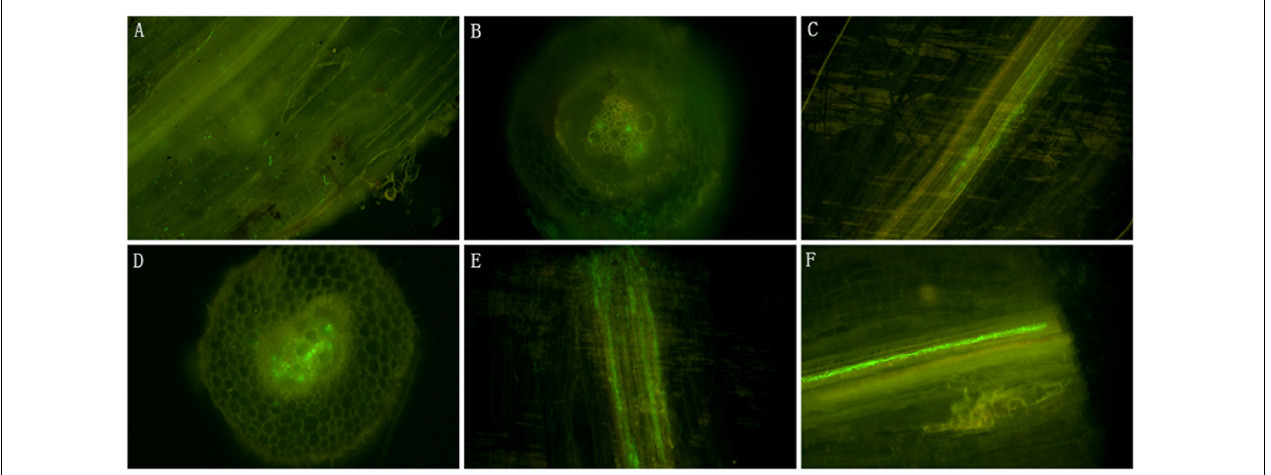
FIGURE 7 | The microscopic micrographs showing endophytic colonization of cotton roots by Fusarium proliferatum 10R-7GFP. (A) Longitudinal sections of the roots inoculated with F. proliferatum 10R-7GFP (25 ◦ C, half past hour postinoculation); (B,C) longitudinal and cross sections of the roots inoculated with F. proliferatum 10R-7GFP at the first day postinoculation, respectively; (D,E) longitudinal and cross sections of the roots inoculated with F. proliferatum 10R-7GFP at the second day postinoculation, respectively. (F) Longitudinal sections of the roots inoculated with F. proliferatum 10R-7GFP at the seventh day postinoculation.